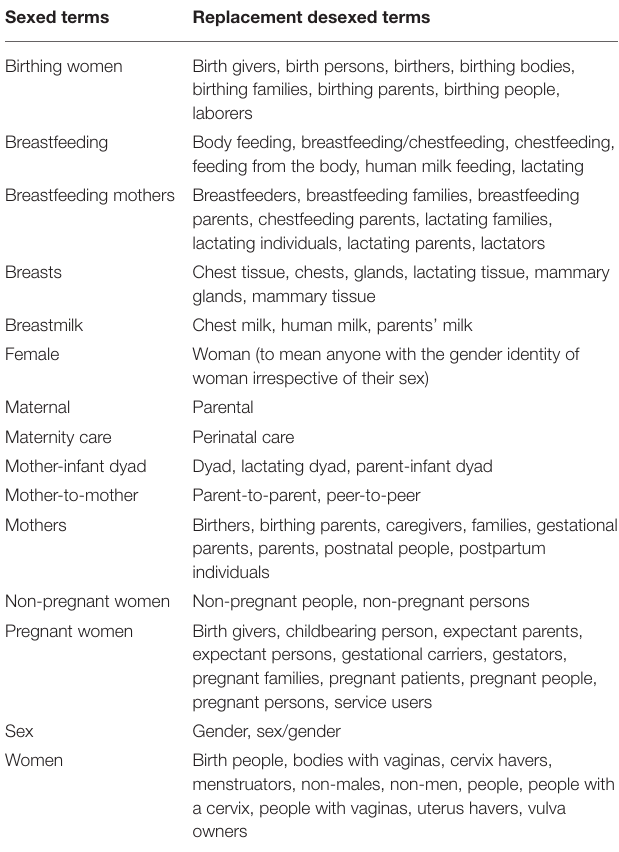
TABLE 1 | Sexed terms and some of their replacement desexed terms. Sexed